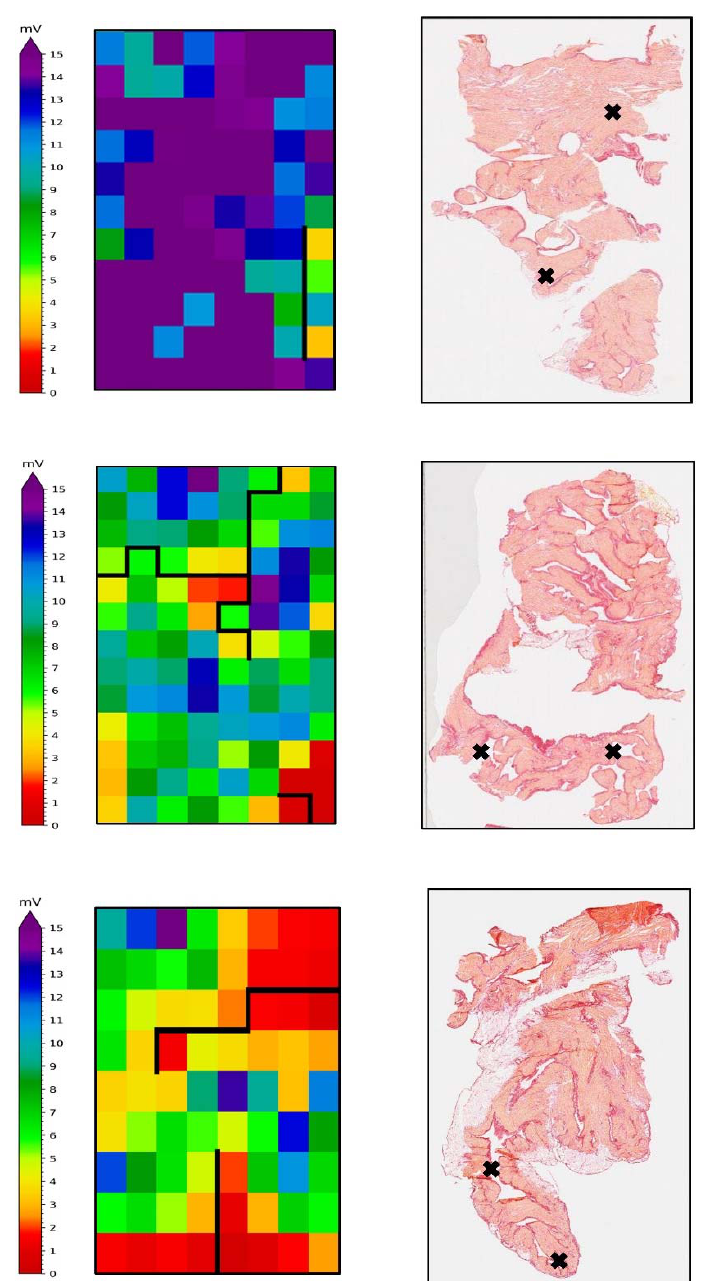
Figure 7. Spatial analysis of electrophysiological and fibrosis parameters in the LAA of patients with ParAF, PeAF, and LS PerAF. In the left panels, high resolution epicardial mappings reveal simultaneously color-coded degree of voltage, and black lines represent block and delay lines; on the right panels, correspondent LAA tissue was stained with picrosirius and percentage of total fibrosis was determined for each subdivision of the slide. Black crosses indicate sub-sectional areas presenting the highest amount of fibrosis.